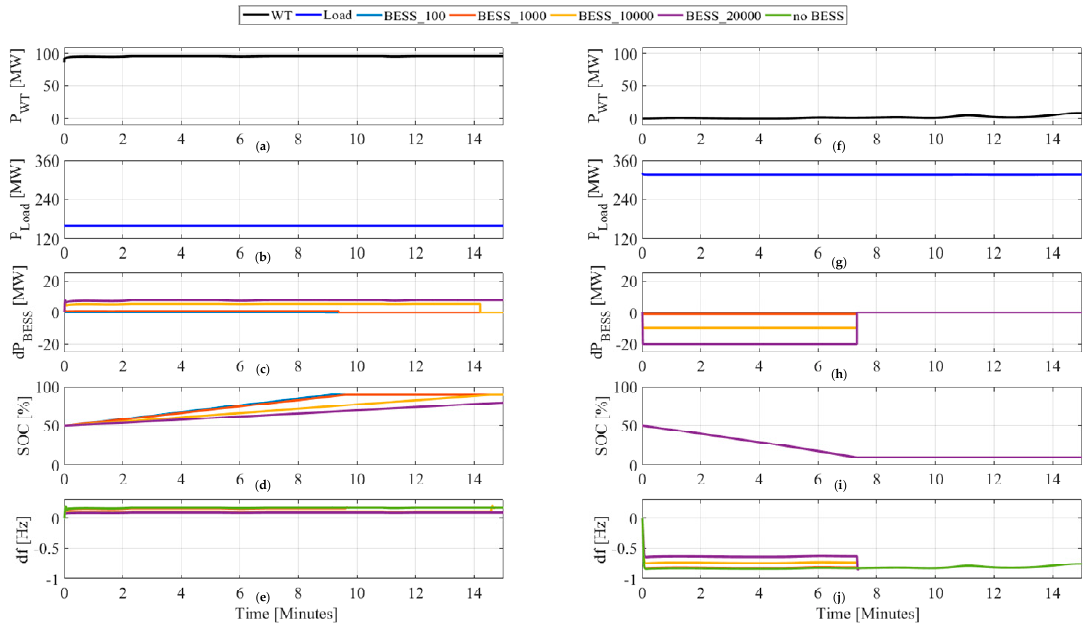
Figure 9. Simulation results for: Second scenario ( a – e ), Third scenario ( f – j ).